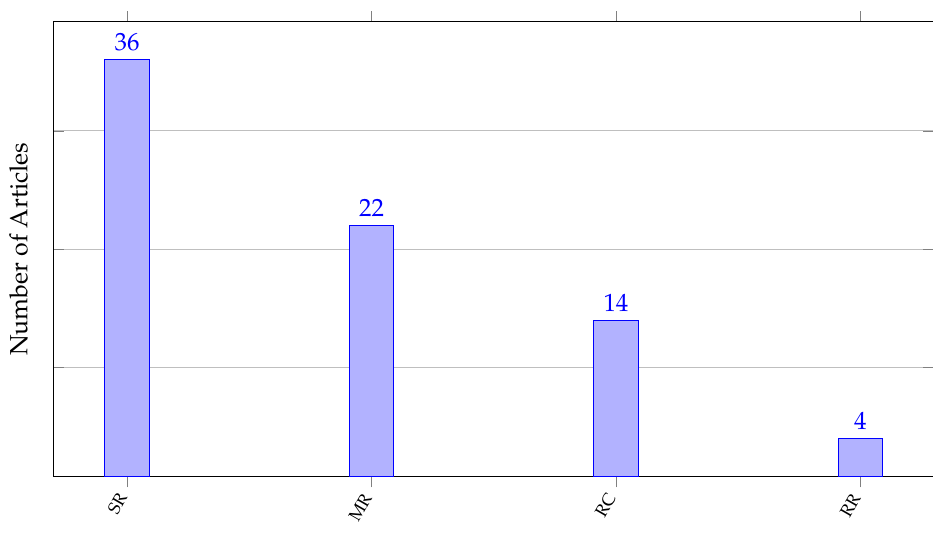
Figure 5. River system in each